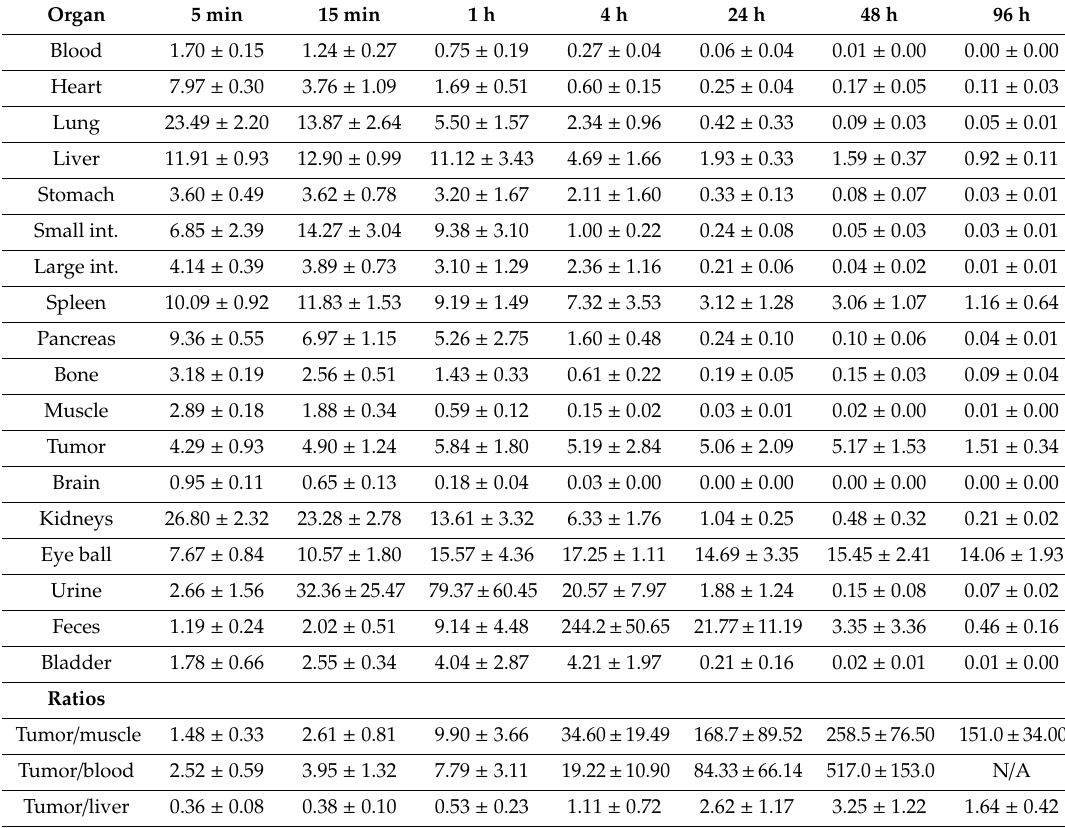
Table 1. Radioactivity biodistribution of B16F10 melanoma-bearing C57BL / 6 mice after intravenous injection of 20 µ Ci of 131